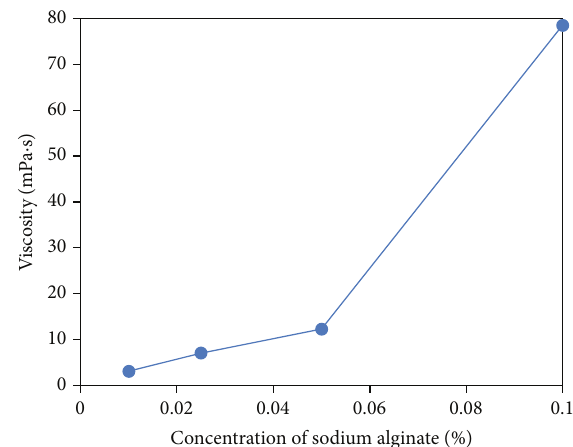
Figure 10: Viscosity of SA solutions at various